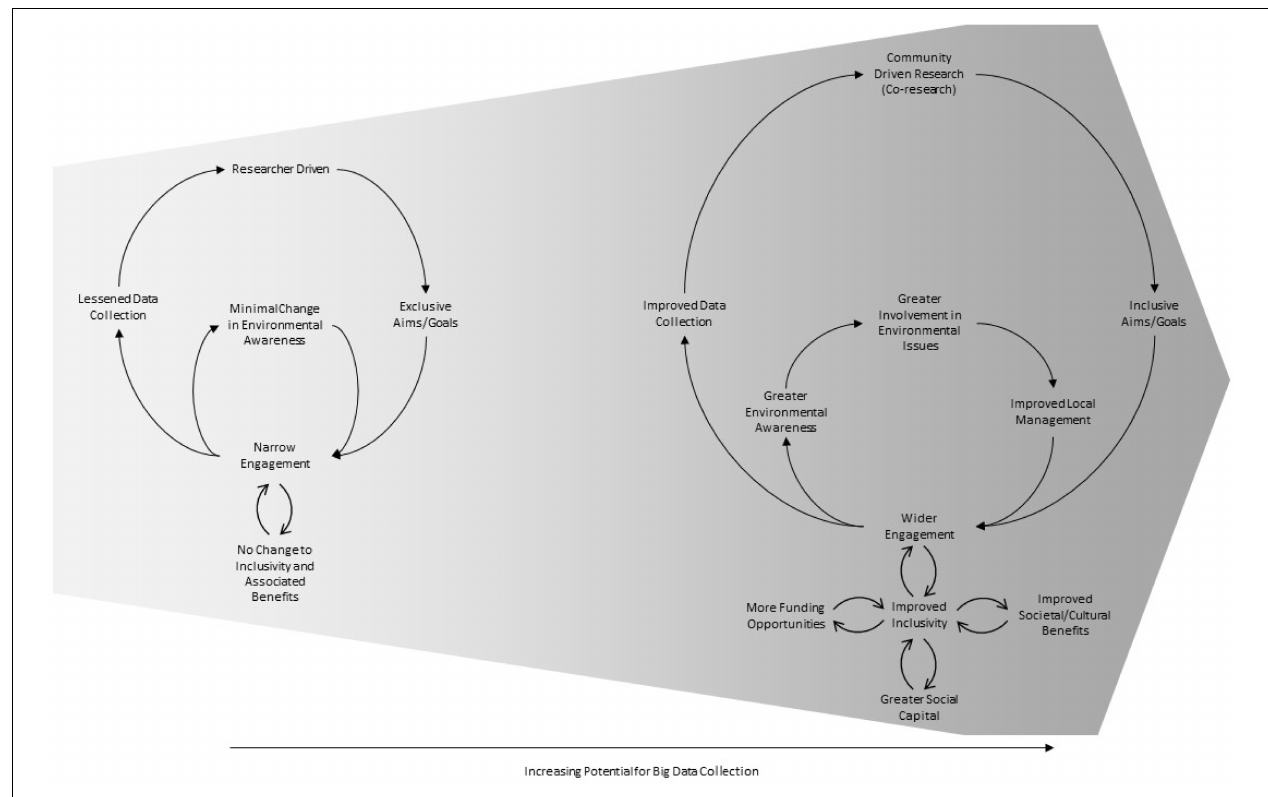
FIGURE 3 | Conceptual cycles demonstrating potential project and societal benefits associated with increased community inclusivity within citizen science projects. Darker shading indicated greater potential for Big Data collection.